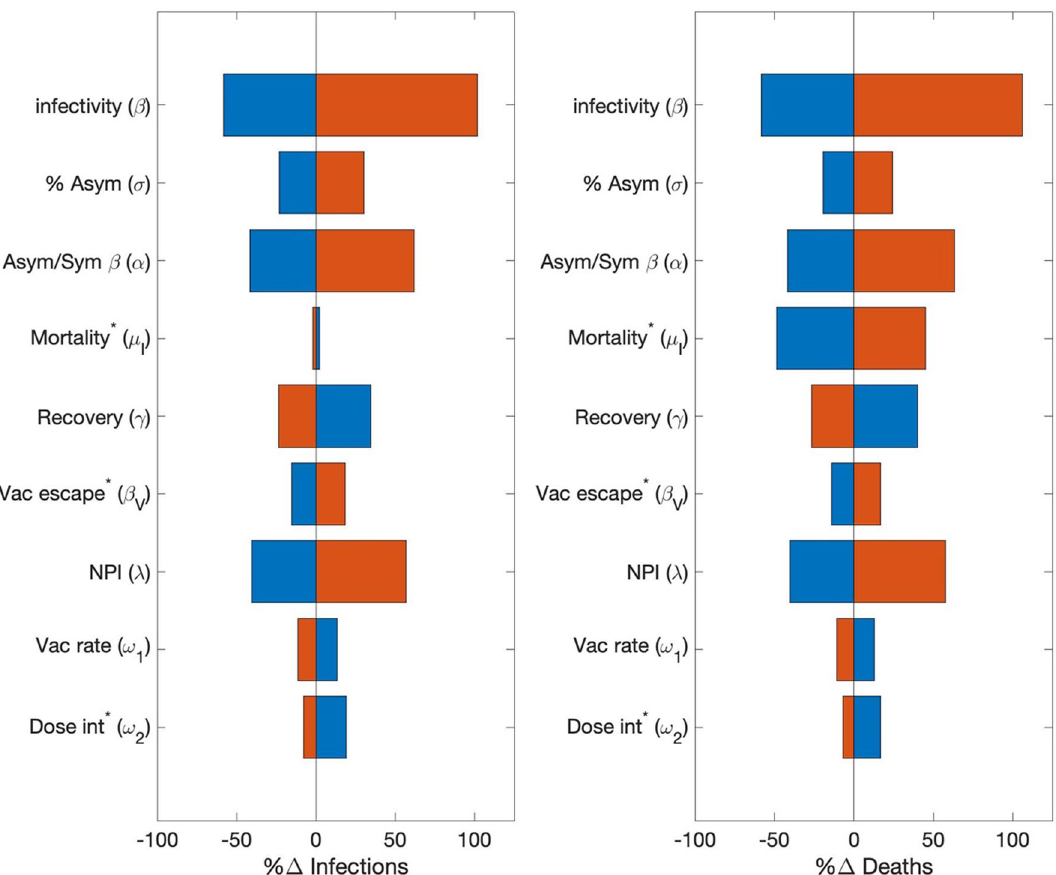
Figure 4. Sensitivity of model predictions, measured by total infections and deaths, to variations in model parameter values, in a one-year simulation (2020) of wild-type viral dynamics. Parameters examined include virus infectivity (β), ratio of asymptomatic versus symptomatic infections (σ), degree of increased infectivity β (due to mobility) of asymptomatic infected individuals compared to symptomatic ones, mortality rate of infected individuals (μ I ), disease recovery rate (γ), vaccine escape rate (β V ), NPI stringency (λ), dosing interval (ω 2 ), vaccination rate (ω 1 ). Asterisk (*) denote parameters that were varied by 50%; other parameters were varied by 5%. Red bar, parameter value increased; blue bar,